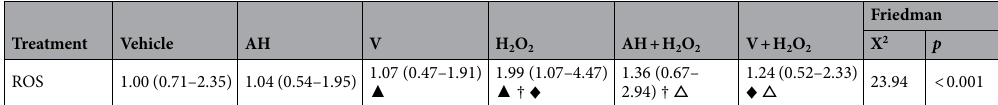
Table 3. ROS (cytosolic and mitochondrial) quantification into differentiated PBMCs exposed 4 h with several treatments. Results are expressed as median and quartiles (in brackets). Units are standardization of the considered signal by protein quantity normalized by vehicle median. AH, Aluminum oxyhydroxide. V, Whole vaccine (Engerix ® ). ▲ p < 0.05 compared to vehicle treatment. △ p < 0.05 compared to H 2 O 2 treatment. † p < 0.05 compared to AH treatment. ♦ p < 0.05 compared to V